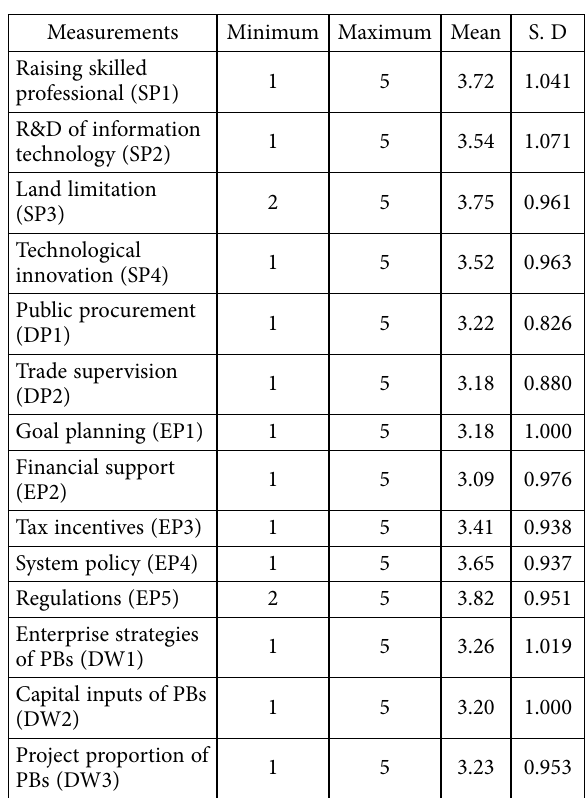
Table 8. Descriptive of observed